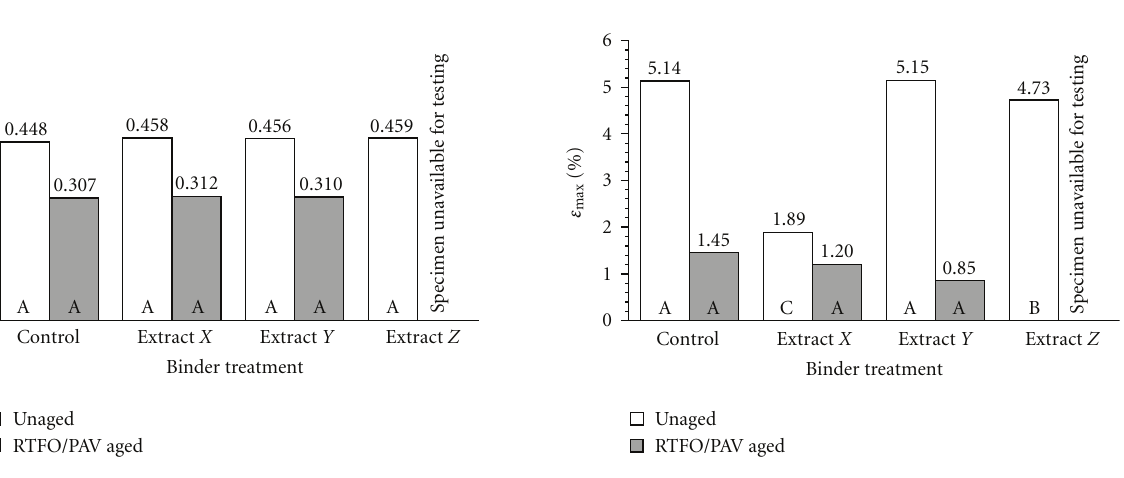
Figure 13: m -value of original and PAV aged control binder and binder with finish extracts tested at − 12 ◦ C. Statistical comparisons were made within each stage of aging.